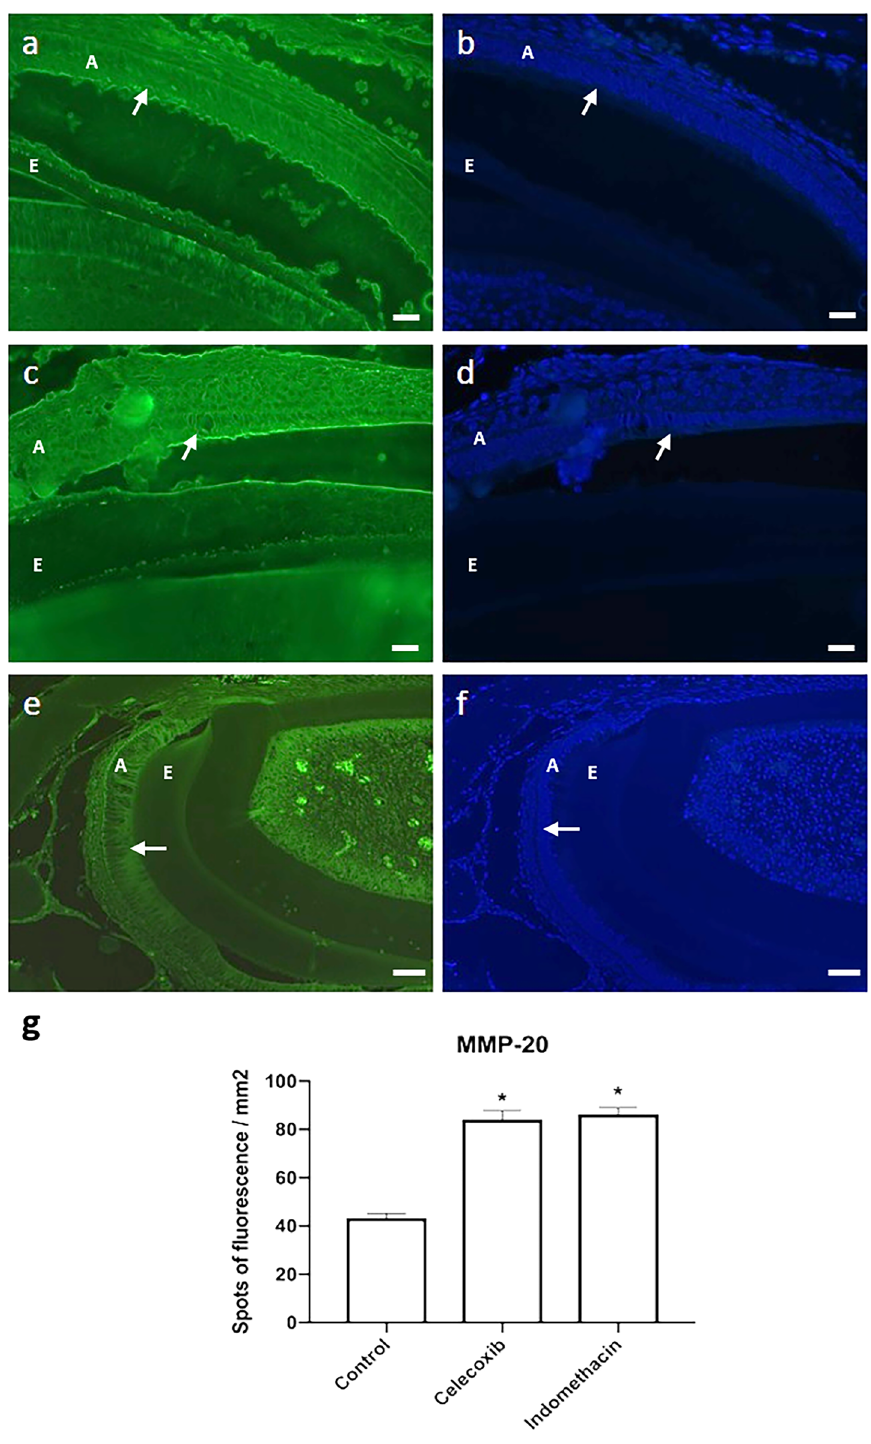
Figure 5. In situ zymography of the control group shows low enzymatic activity (40× / scale = 20 µm) ( a ). Celecoxib (40× / scale = 20 µm) ( c ) and indomethacin treatment (20×/scale = 50 µm) ( e ) shows an increased synthesis of the enzyme. Depicts nuclear DAPI labeling (40×/scale = 20 µm) ( b and d ), (20×/scale = 50 µm) ( f ). A: ameloblasts, E: enamel